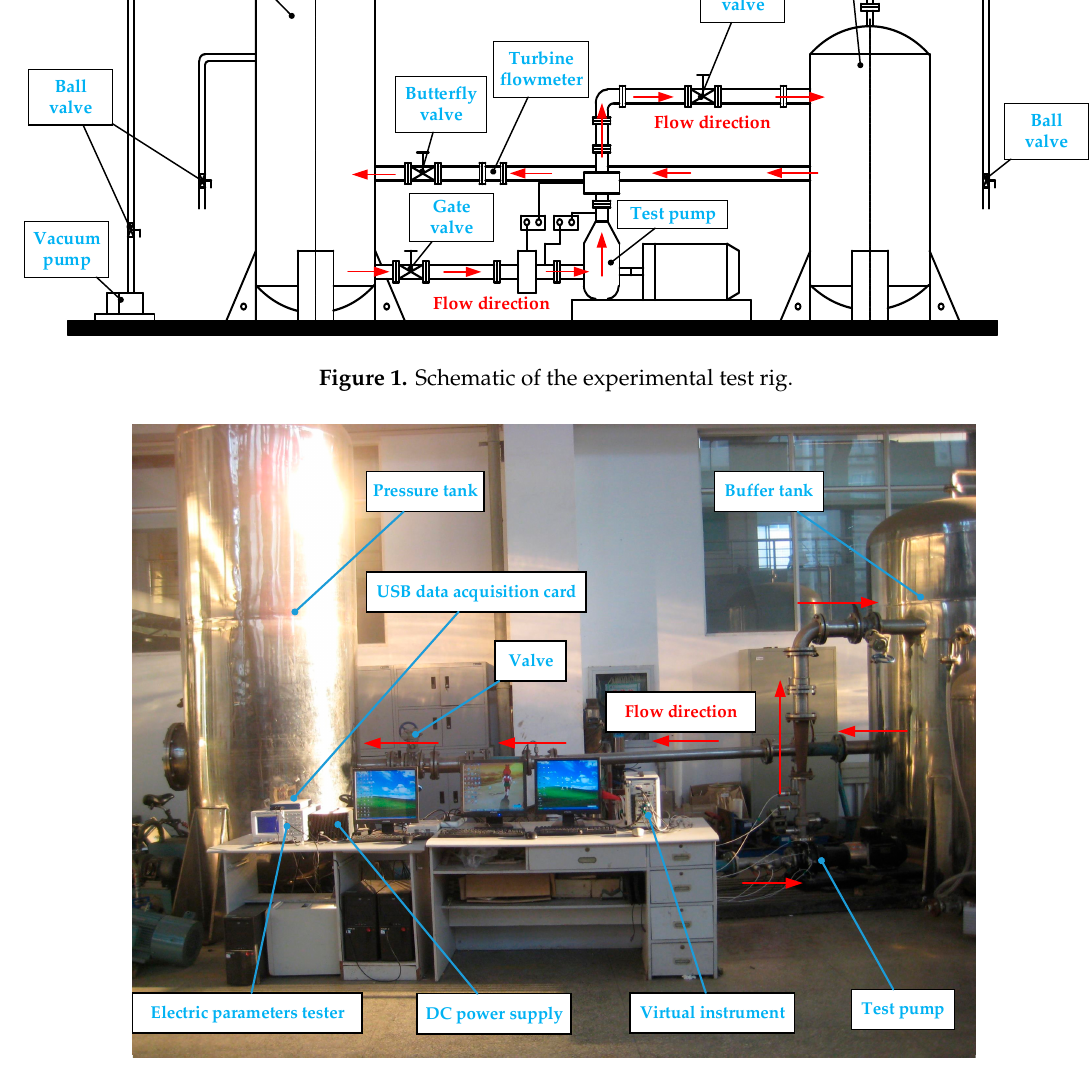
Figure 2. Experimental set ‐ up with instrumentation.